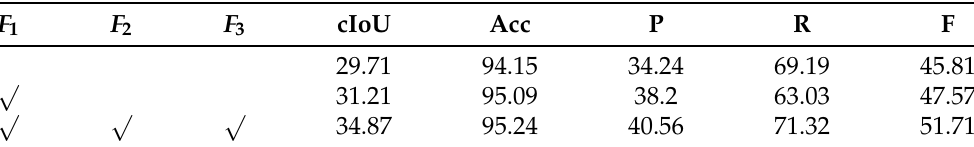
Table 6. Ablation study for skip connection (RES101). ing features to generate the final